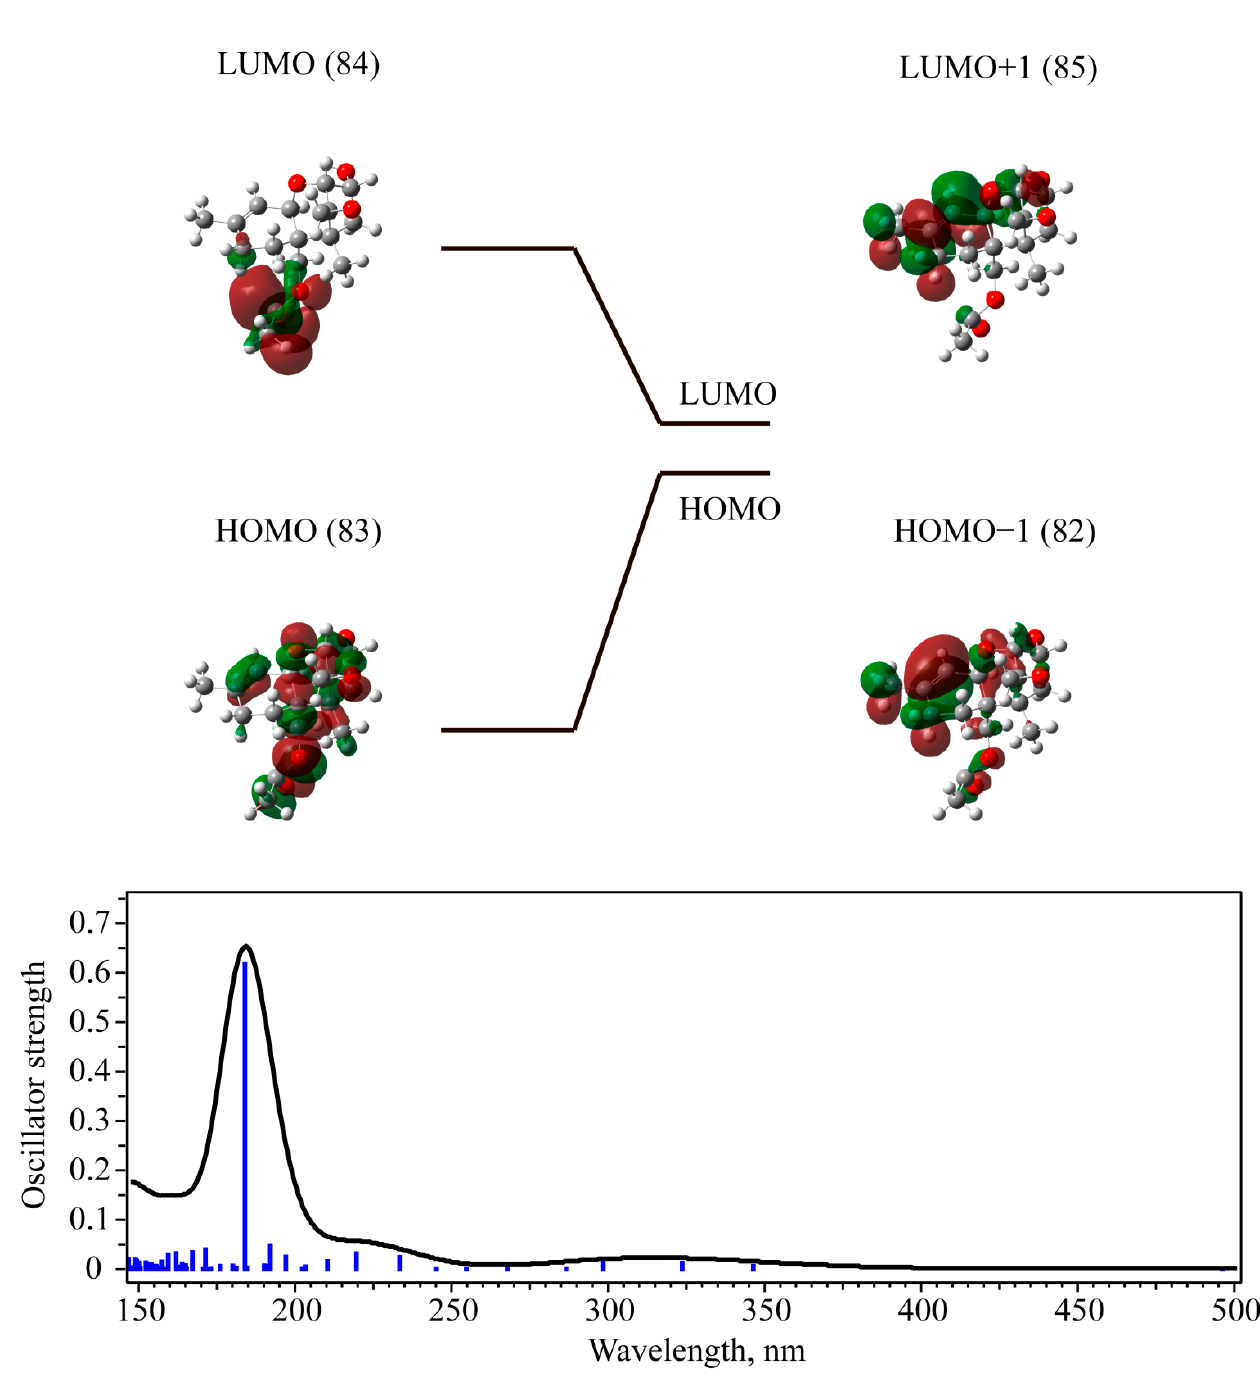
Figure 7. TD-DFT calculated molecular orbitals (HOMO-1 (82), HOMO (83), LUMO (84), LUMO+1 (85)) for 3-deacetylcalonectrin in methanol ( top ) and calculated UV-Vis absorbance spectra ( bottom ).